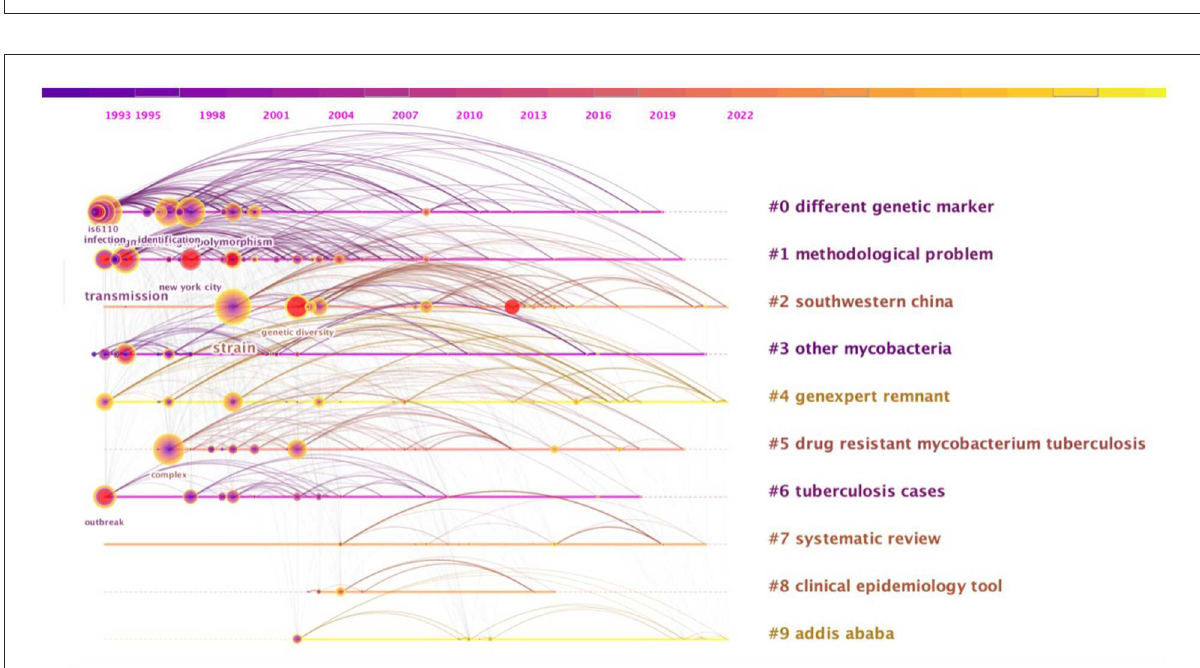
FIGURE5 Clustered analysis of co-occurring keywords on tuberculosis molecular epidemiology.